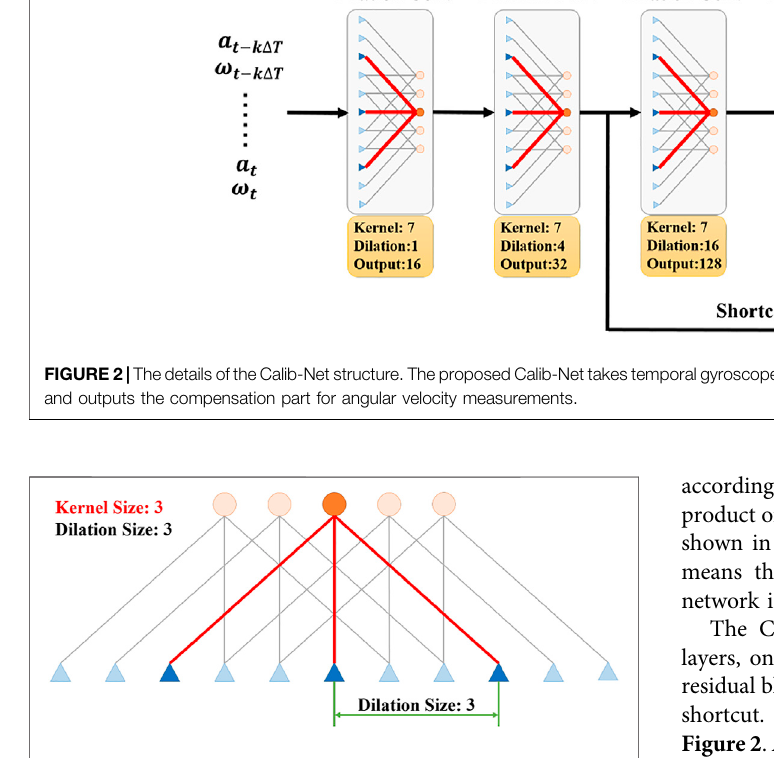
Frontiers in Robotics and AI |